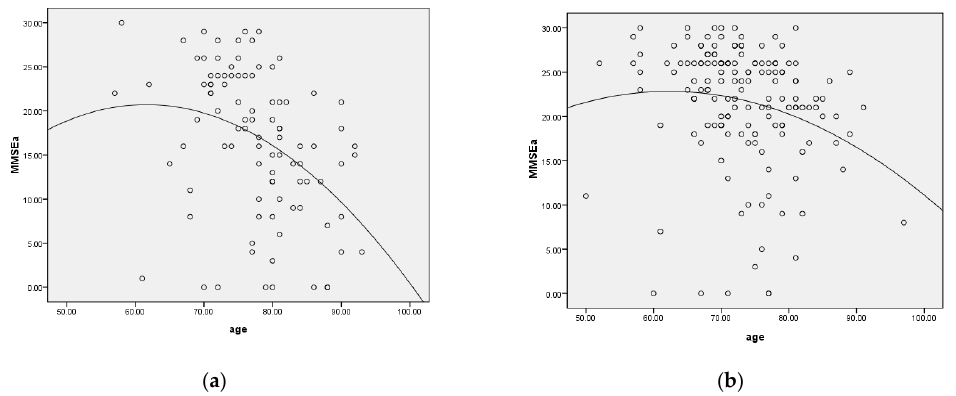
Table 5. The LASSO regression analysis of demographic variables, three dietary patterns (DPs) and MMSE score.